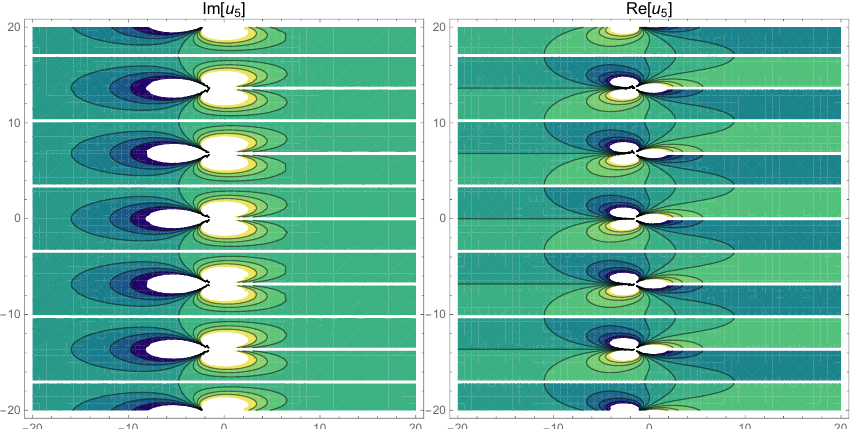
Figure 9. The 3D figures of Equation (18).